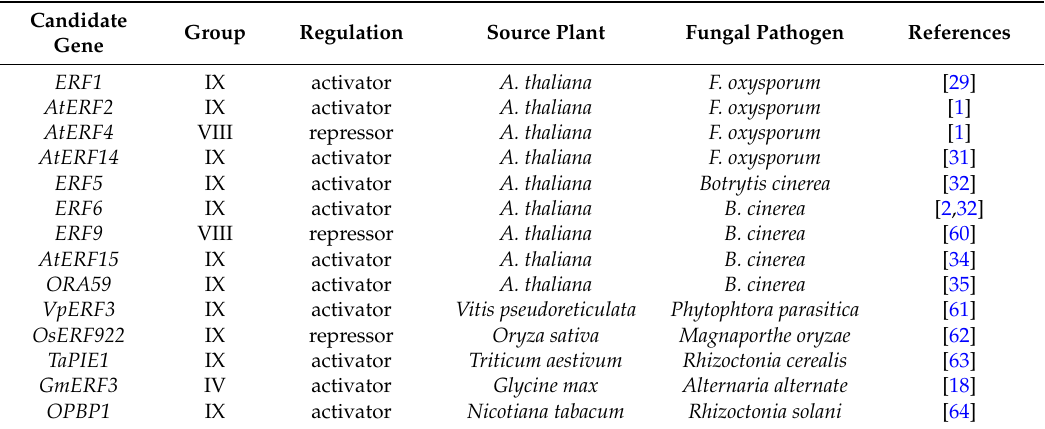
Table 2. Role of ERFs in response to fungal pathogens encountered by plants.